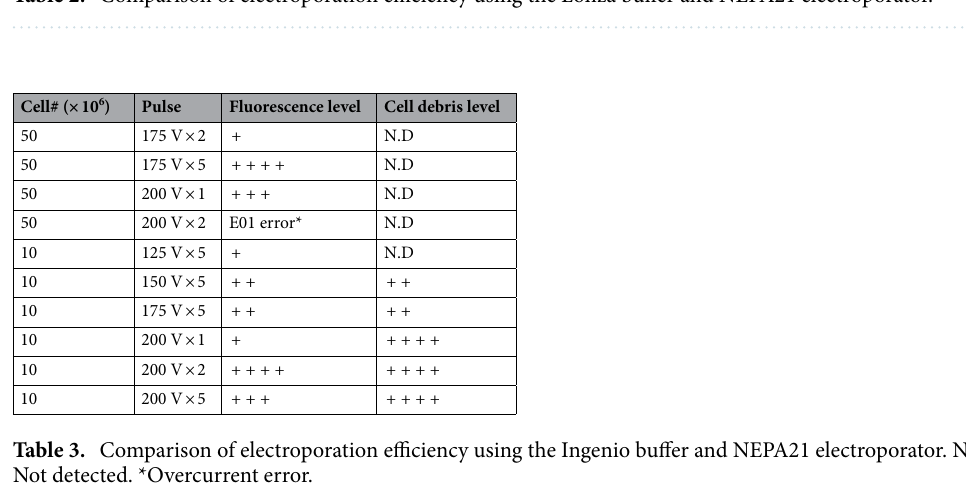
Table 3. Comparison of electroporation efficiency using the Ingenio buffer and NEPA21 electroporator. N.D.: Not detected. *Overcurrent error.